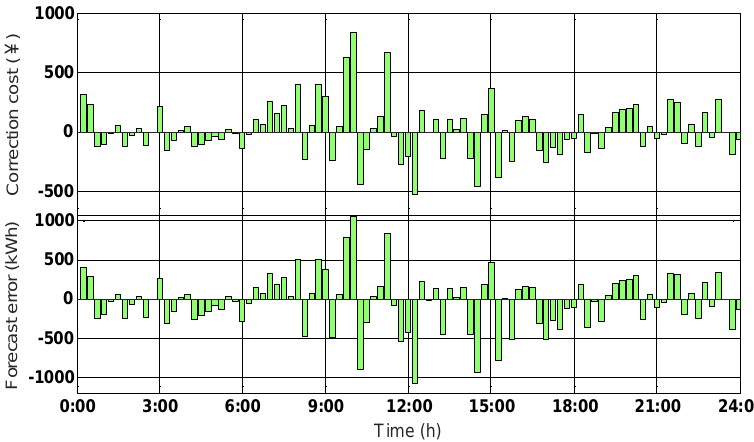
Figure 13. The correction cost and forecast error in Scenario One by online local optimization.